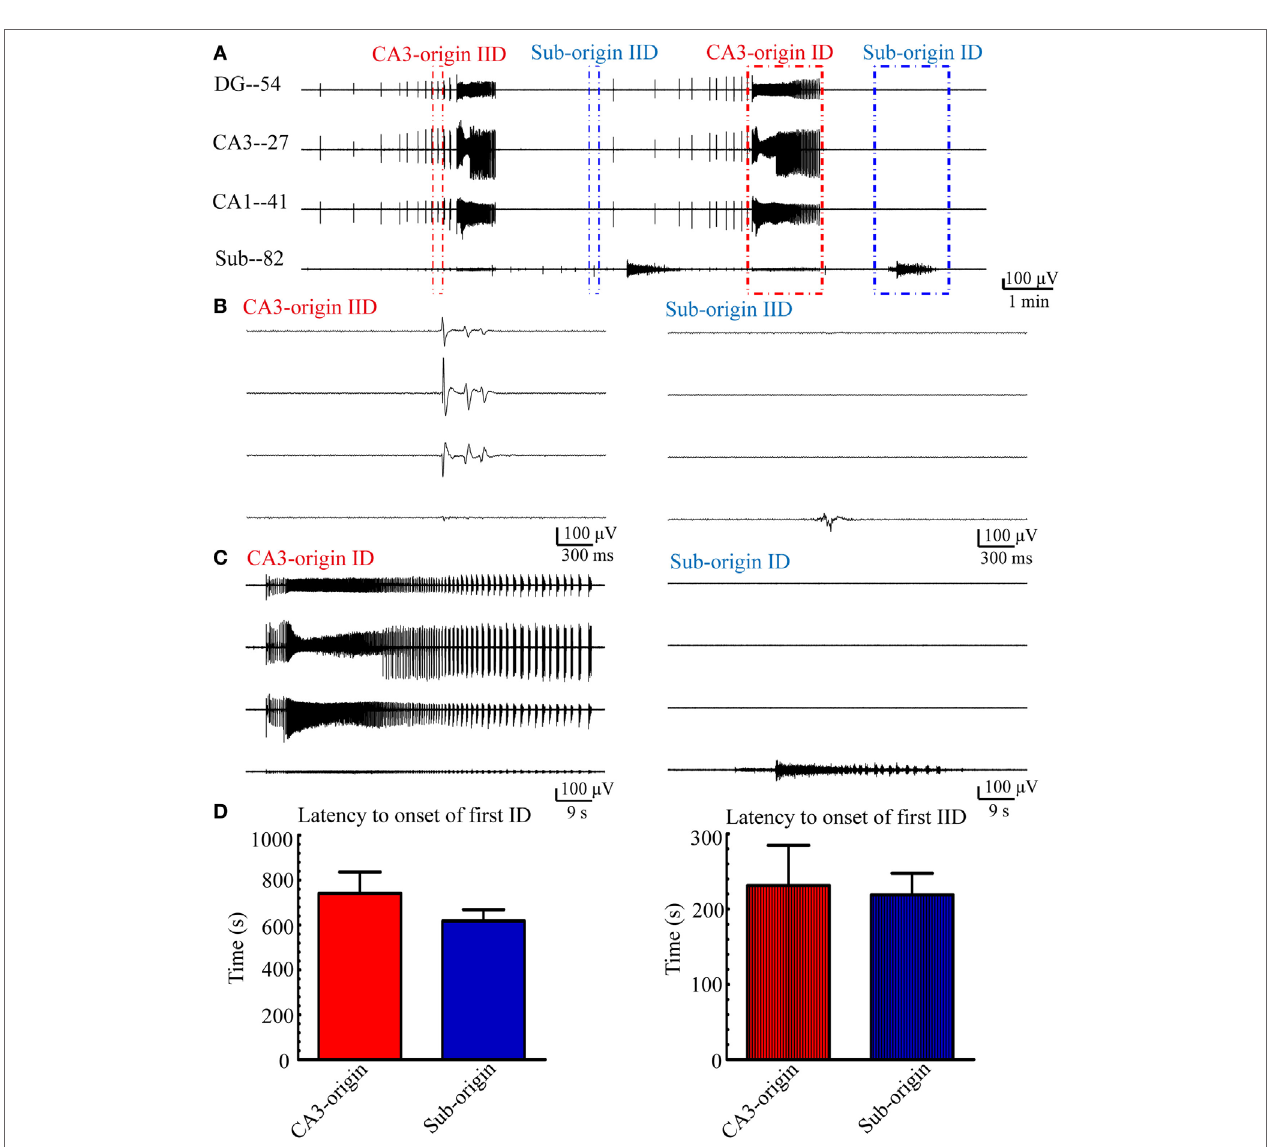
FigUre 3 | ca3- and sub-origin epileptiform discharges . (a) Epileptiform discharges recorded by four electrodes (numbers 54, 27, 41, 82) in the slice shown in Figure 1a , which represents the epileptiform discharges in the DG, CA3, CA1, and subiculum, respectively. The red and blue rectangles represent the CA3- and Sub-origin epileptiform discharges, respectively. (B) The interictal-like discharges (IIDs) in rectangles in (a) are displayed in an expanded time scale. (c) The ictal-like discharges (IDs) in rectangles in (a) are shown on an expanded time scale. (D) Latency to onset of the first CA3-origin ID/IID in the hippocampus proper and Sub-origin ID/IID in the subiculum. Data were presented as mean ± SEM. There was no significant difference between them ( P > 0.05, paired t -test, n =